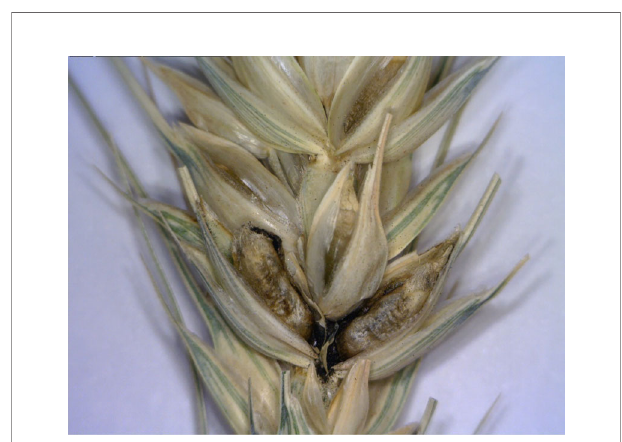
FIGURE 1 | Wheat spikelets infected by Tilletia